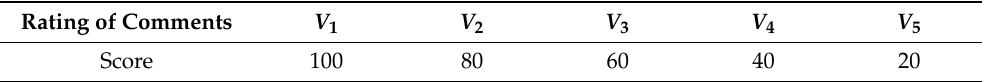
Table 7. Evaluation values of different evaluation